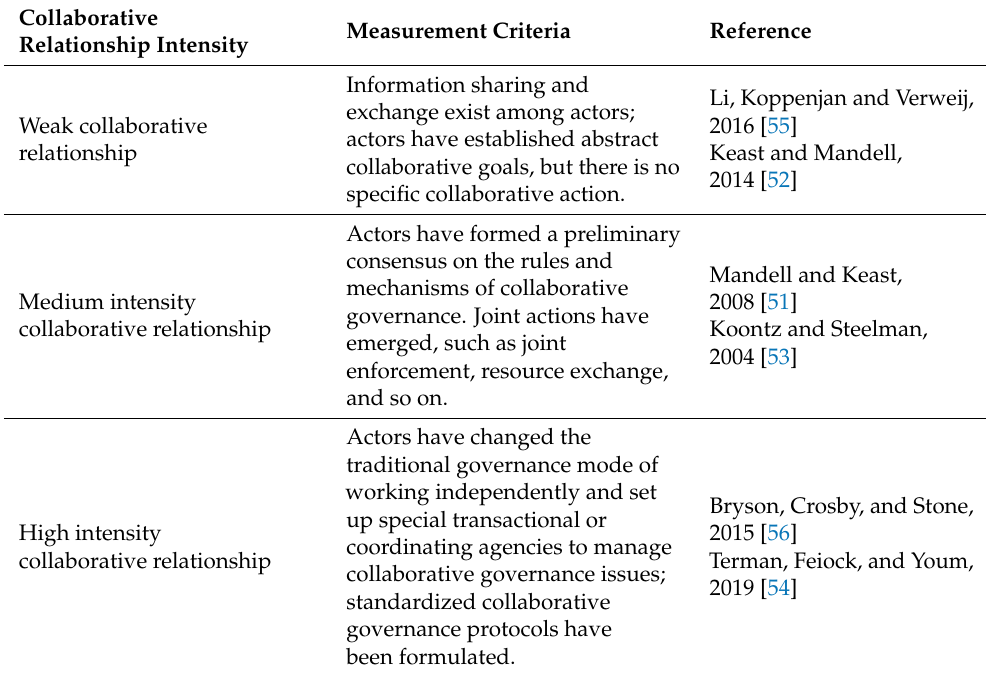
Table 1. Measurement of the intensity of coastal zone environment collaborative governance relationships.